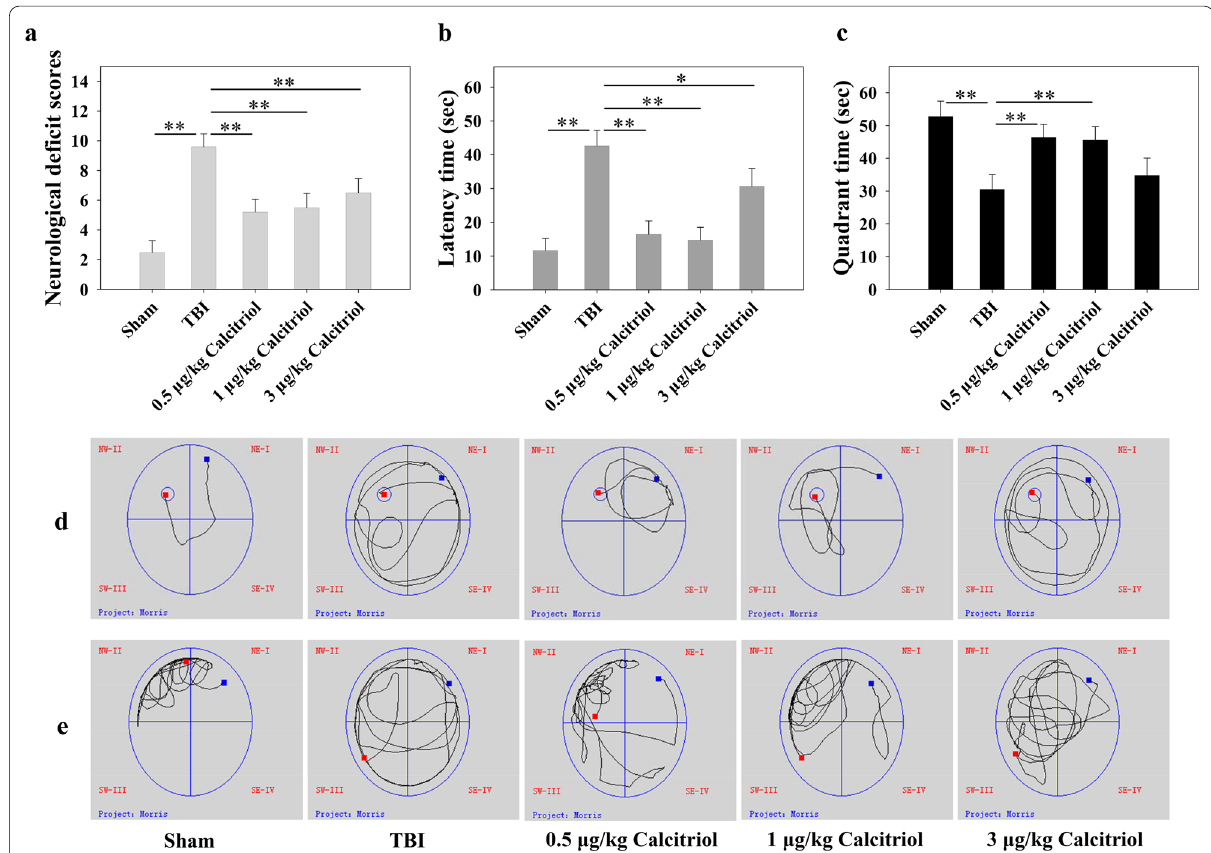
Fig. 1 The neuroprotective effects of calcitriol in TBI-induced neurological deficits and memory dysfunction. a The variation in neurological deficits at 14 days after treatment was determined by neurological severity score tests. b The time (seconds) spent finding the submerged platform at 14 days. c The time (seconds) spent on exploring the quadrant that initially contained the platform at 14 days. d Representative traces indicating the sample paths of the mice in the orientation navigation test. e Representative traces in the probe test indicating the sample paths of the mice after the platform was removed. Data are presented as means SEM ( n 10). * P < 0.05 and ** P < 0.01 versus the indicated groups. (Sham: sham-operated ± = group; TBI: TBI model group; Calcitriol: TBI calcitriol treatment +